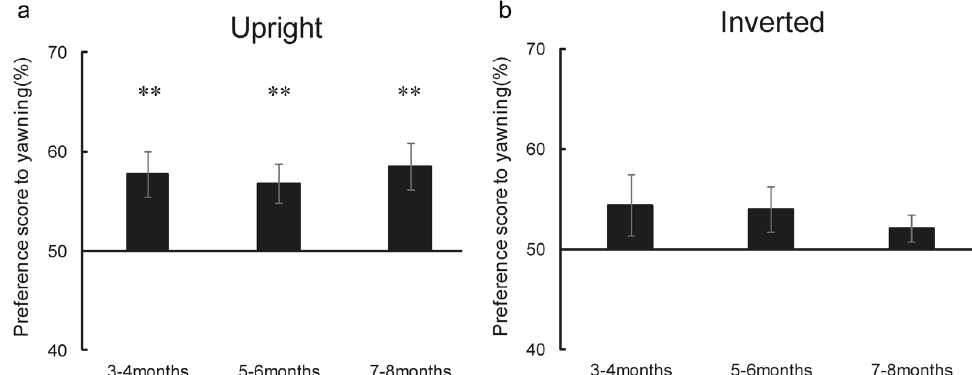
Figure 1. Results of Experiment 1. ( a ) Preference scores for the yawning movements in upright condition (Experiment 1a). ( b ) Preference scores for the yawning movements in inverted condition (Experiment 1b). Error bars represent ± 1 SEM. ** p < 0.01